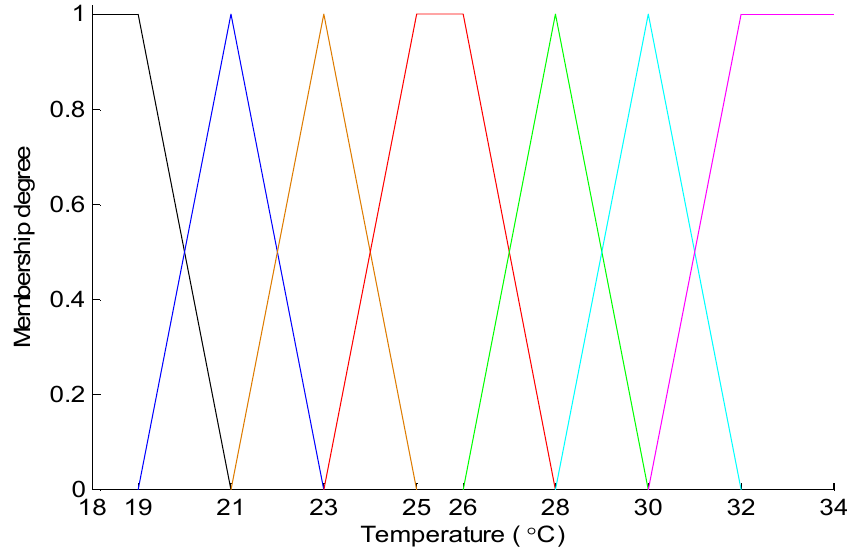
Figure 1. Temperature membership functions in summer.